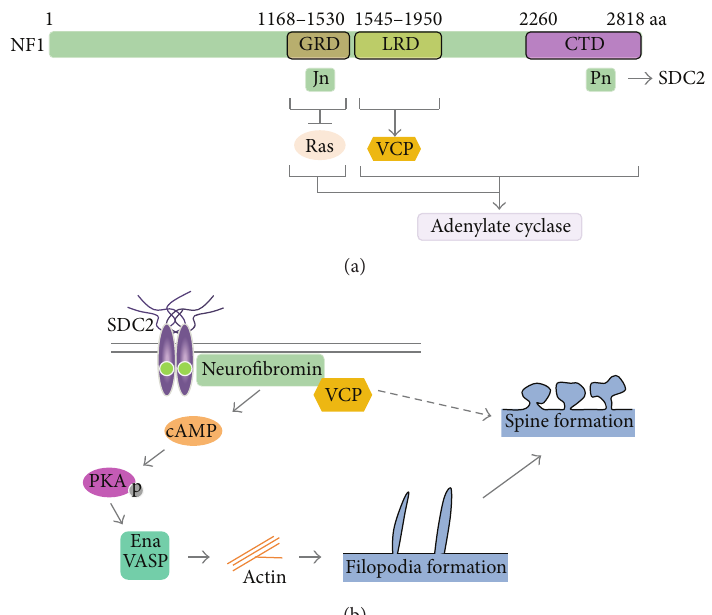
Figure 2: Function of neurofibromin in neurons. (a) Neurofibromin-interacting proteins. The Jn and Pn fragments interact with syndecan-2. The leucine-rich domain (LRD) binds VCP. The GAP-related domain (GRD) downregulates the Ras pathway. Both GRD and the C-terminal half of neurofibromin are involved in adenylate cyclase activity regulation. CTD, C-terminal region. (b) Neurofibromin controls dendritic filopodia and spine formation through the PKA-Ena/VASP and VCP pathways, respectively.